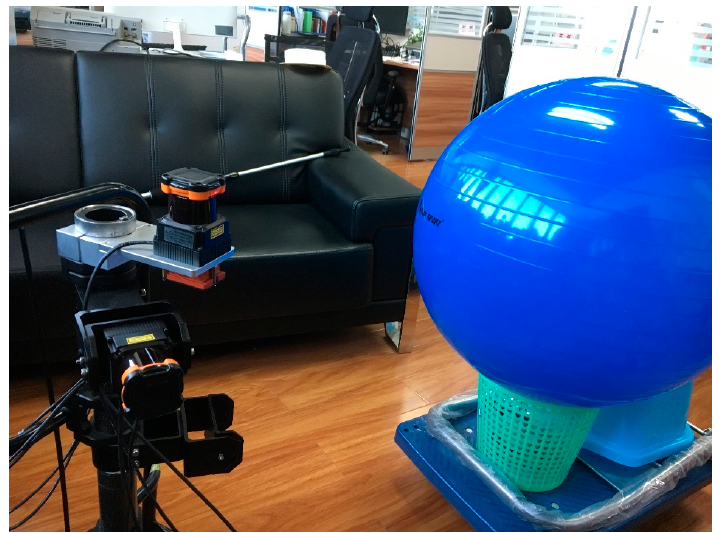
Figure 4. Sensor assembly platform and mobile sphere. The Laser1 LRF is assembled horizontally, and the Laser2 LRF is assembled vertically. The radius of the mobile spherical target is 0.325